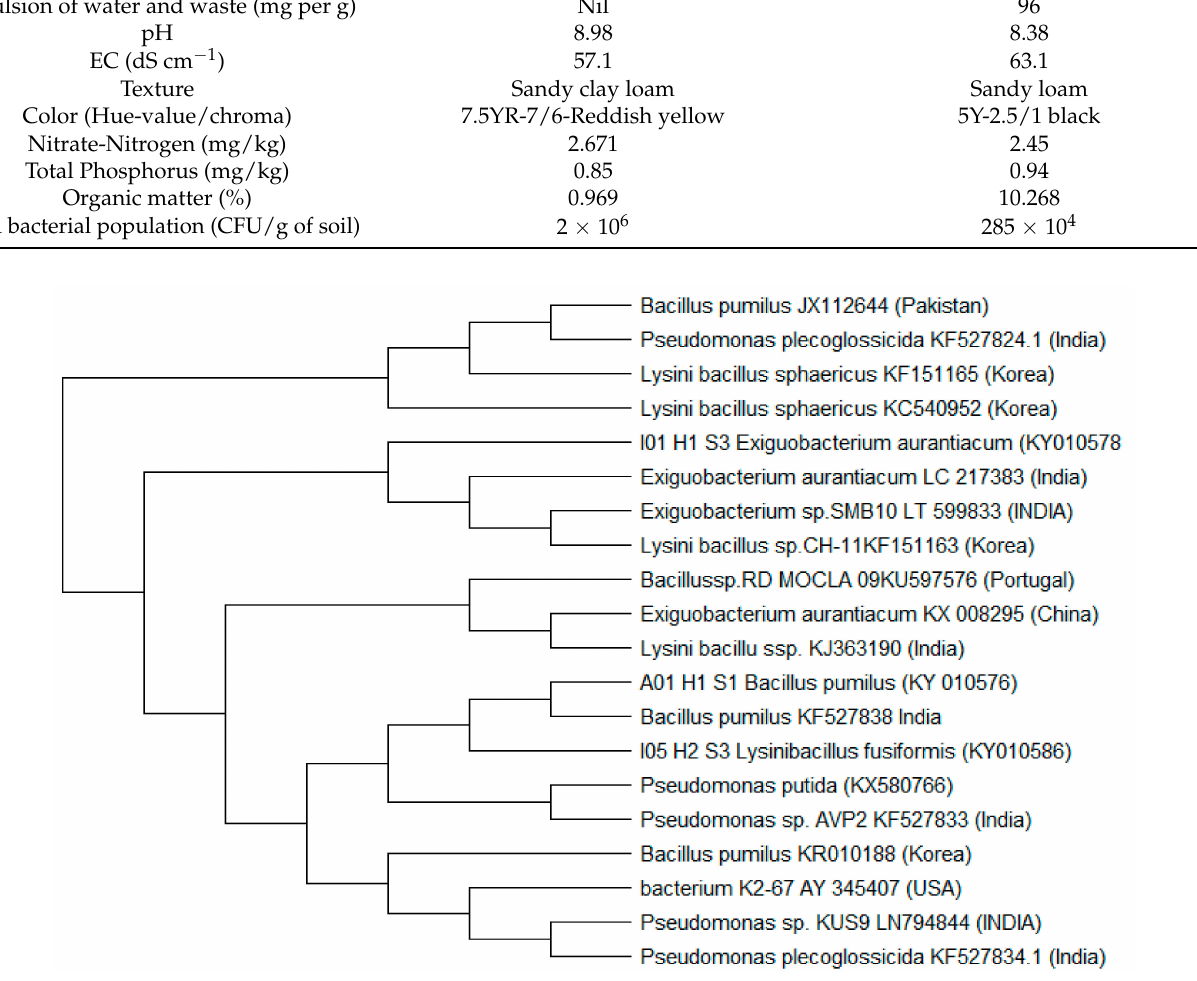
Figure 1. Evolutionary relationships of microbes (used for consortium preparation). The evolutionary history was inferred using the Neighbor-Joining method. The optimal tree with the sum of branch length = 68.70927977 is shown. The evolutionary distances were computed using the Maximum Composite Likelihood method and are in the units of the number of base substitutions per site. The analysis involved 20 nucleotide sequences. All ambiguous positions were removed for each sequence pair. There was a total of 900 positions in the final dataset. Evolutionary analyses were conducted in MEGA